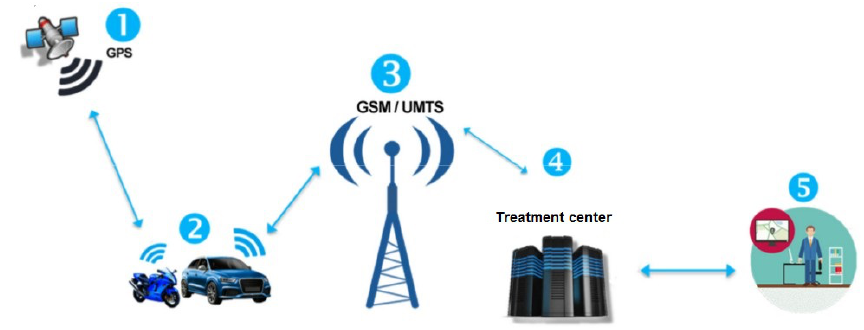
Figure 5. Overview of the system elements and their interactions to perform real-time trace